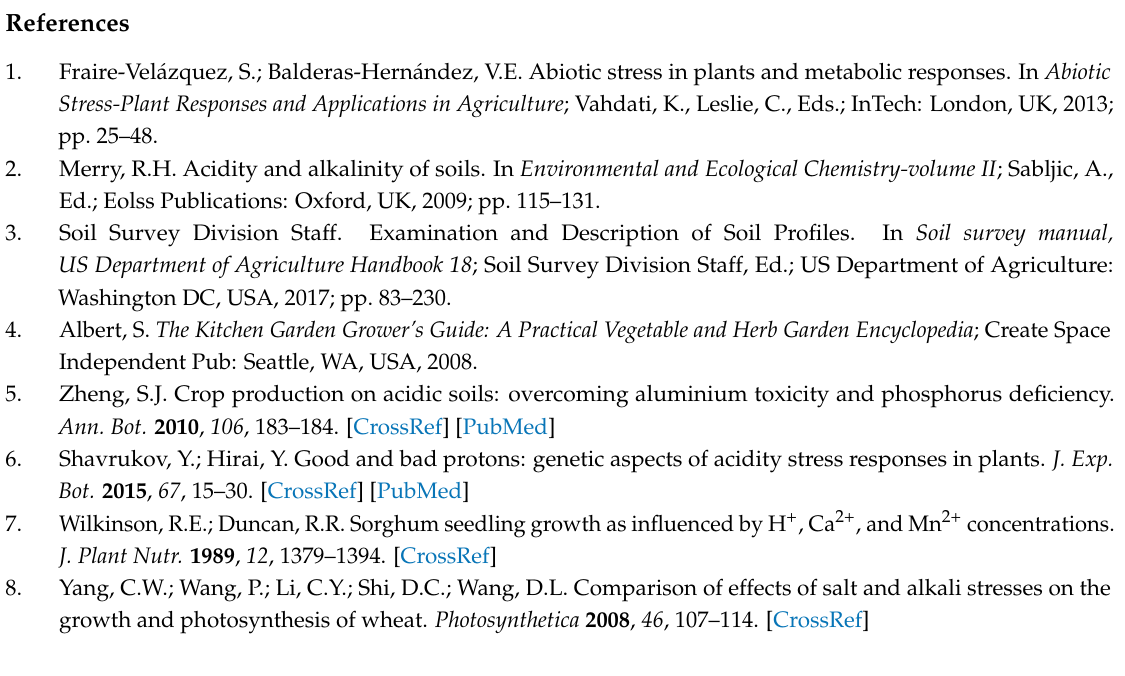
Figure S1: Work flow scheme of the conducted